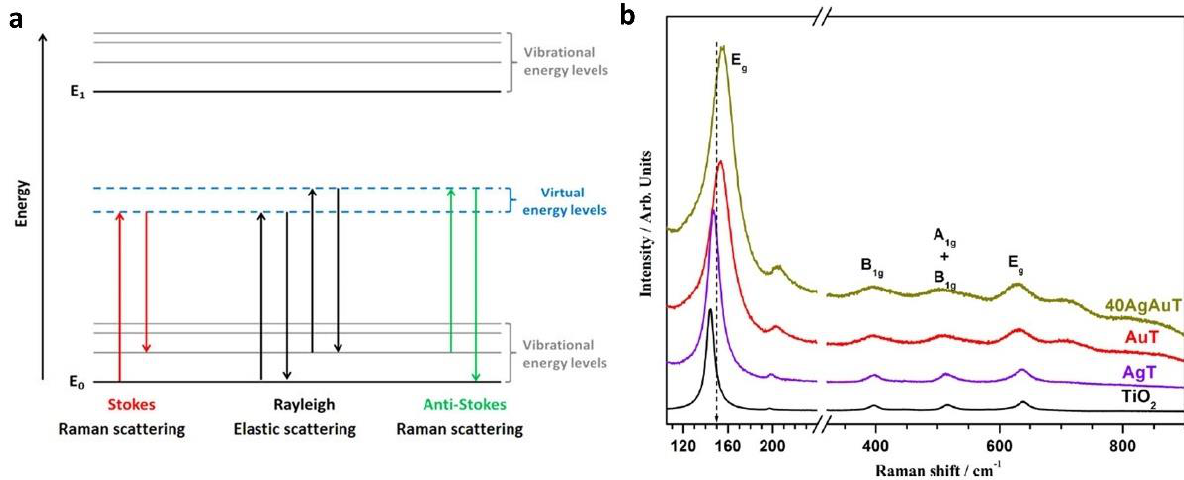
Figure 18. ( a ) Schematic of the Raman effect as utilized in Ember et al. [204] The shifting modes of inelastic scattering often evinced in Raman spectroscopy from the Stokes band (Left), where an inelastic vibration is excited to the anti-Stokes band (Right), where an already excited vibrational state is de-excited, the latter resulting in a higher energy photon being emitted as opposed to the former. Lastly, is the case of the Rayleigh band (Center) where the light scattered by the sample is done so without any loss of energy. Reprinted and adapted with permission and no modifications from Ref [204] with attribution and adherence to Creative Commons Attribution License (CC BY) 4.0. Copyright Nature Publishing Group (2017). ( b ) Raman spectroscopy as a characterization method. Raman studies of TiO 2 , Ag–TiO 2 , Au–TiO 2 , and Ag on Au–TiO 2 composites. As discussed in Patra et al. [205], active Raman modes at particular wavelengths allow for the confirmation of the characteristic features of anatase TiO 2 , as well as the confirmation of SERS resulting in frequency shifts between SERS and normal Raman spectra of molecules observed in the peak shifts and broadening after deposition of gold on TiO 2 for the differing composite systems. Reprinted with permission from Ref [205] Copyright John Wiley and Sons (2016).